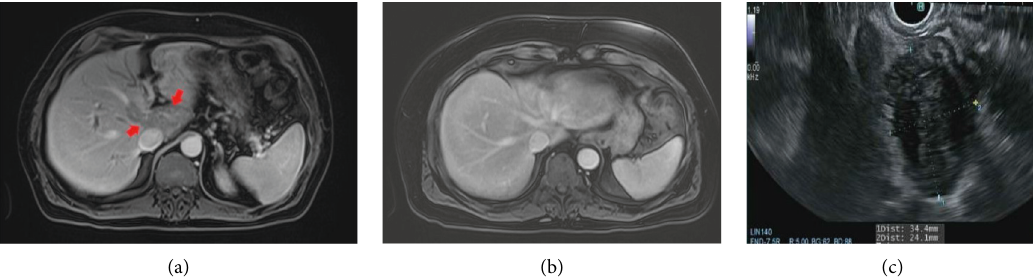
Figure 1: (a) Magnetic resonance imaging (MRI) of the abdomen demonstrating hepatic IPTprior to treatment with steroid taper. (b) MRI of the abdomen after treatment showing complete resolution of hepatic IPT. (c) Endoscopic ultrasound demonstrating a periportal mass.